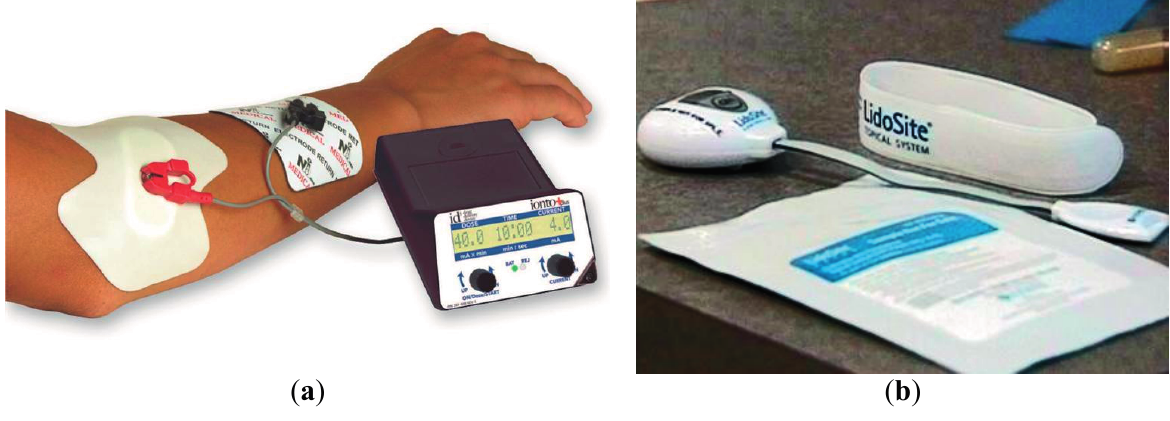
Figure 9. Commercially developed iontophoretic delivery systems: ( a ) Phoresor ® and ( b ) Lidosite ®